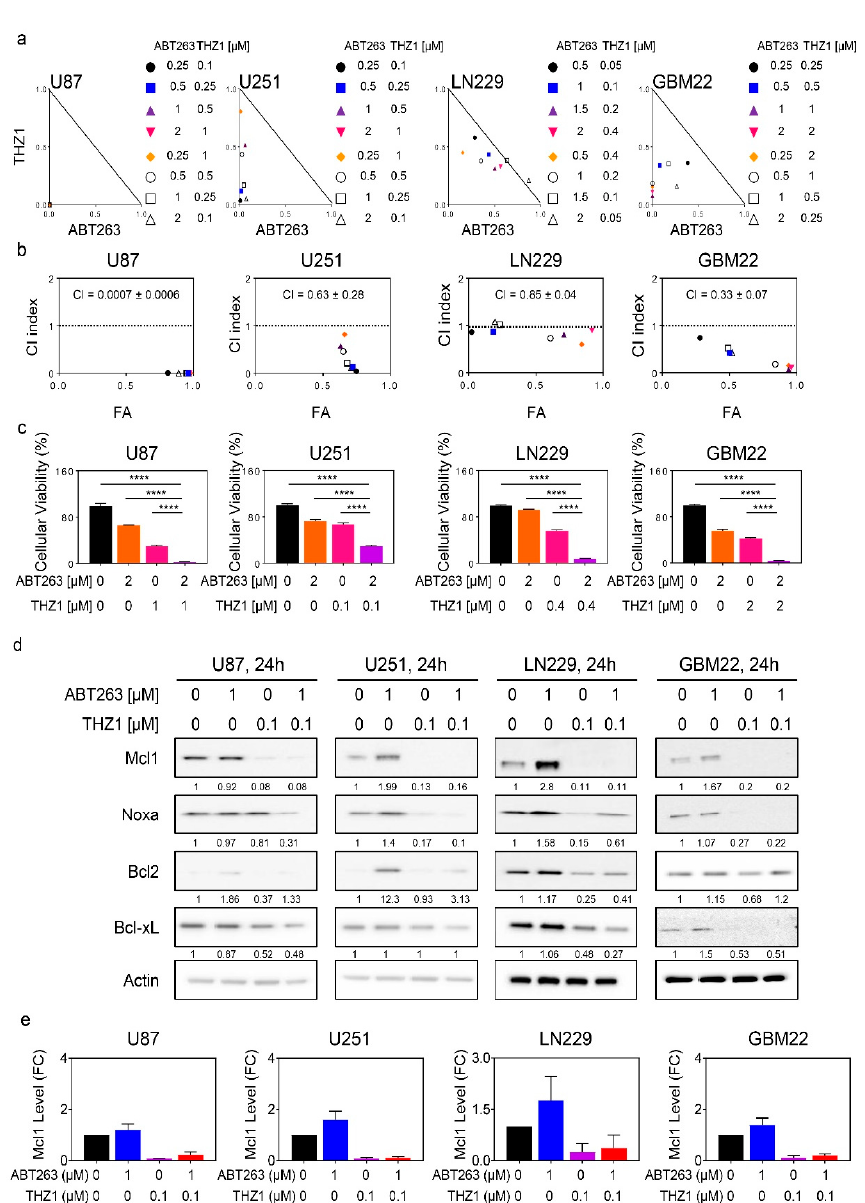
Figure 3. THZ1 and BH3 ‐ mimetics act synergistically to reduce the viability of glioblastoma model systems in vitro. ( a ) Cellular viability data of U87, U251, LN229, and GBM22 cells treated with ABT263, THZ1 or the combination of both. Isobolograms are shown; ( b ) Combination index (CI) value of samples treated in ( a ). CI value < 1: synergistic, CI value = 1: additive, and CI > 1: antagonistic. The dotted line represents additivity (CI value = 1). FA: fraction affected; ( c ) The graphs show cellular viability data of U87, U251, LN229, and GBM22 cells treated with ABT263, THZ1, or a combination of both ( n = 4). ANOVA was used for statistical analysis; ( d ) Standard western blots of cell lysates of U87, U251, LN229, and GBM22 cells treated with ABT263, THZ1, or the combination of both for 24 h. Actin is used as a loading control. The protein expression levels of Mcl1, Noxa, Bcl2, and Bcl-xL were quantified by using ImageJ (shown in cursive font). Uncropped blots are shown in Figure S10; ( e ) The protein expression level of Mcl1 treated with ABT263, THZ1, or the combination of both for 24 h in U87, U251, LN229, and GBM22 cells. FC: fold change. Shown are means and SD ( n = 2–3). **** p <